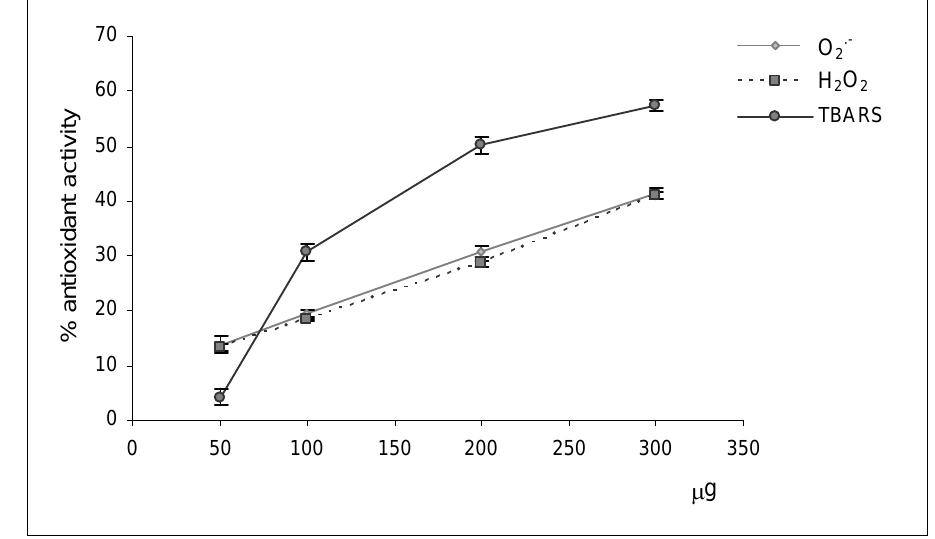
Figure 2 . Antioxidant activity of M. neapolitana Ten. methanolic extract.